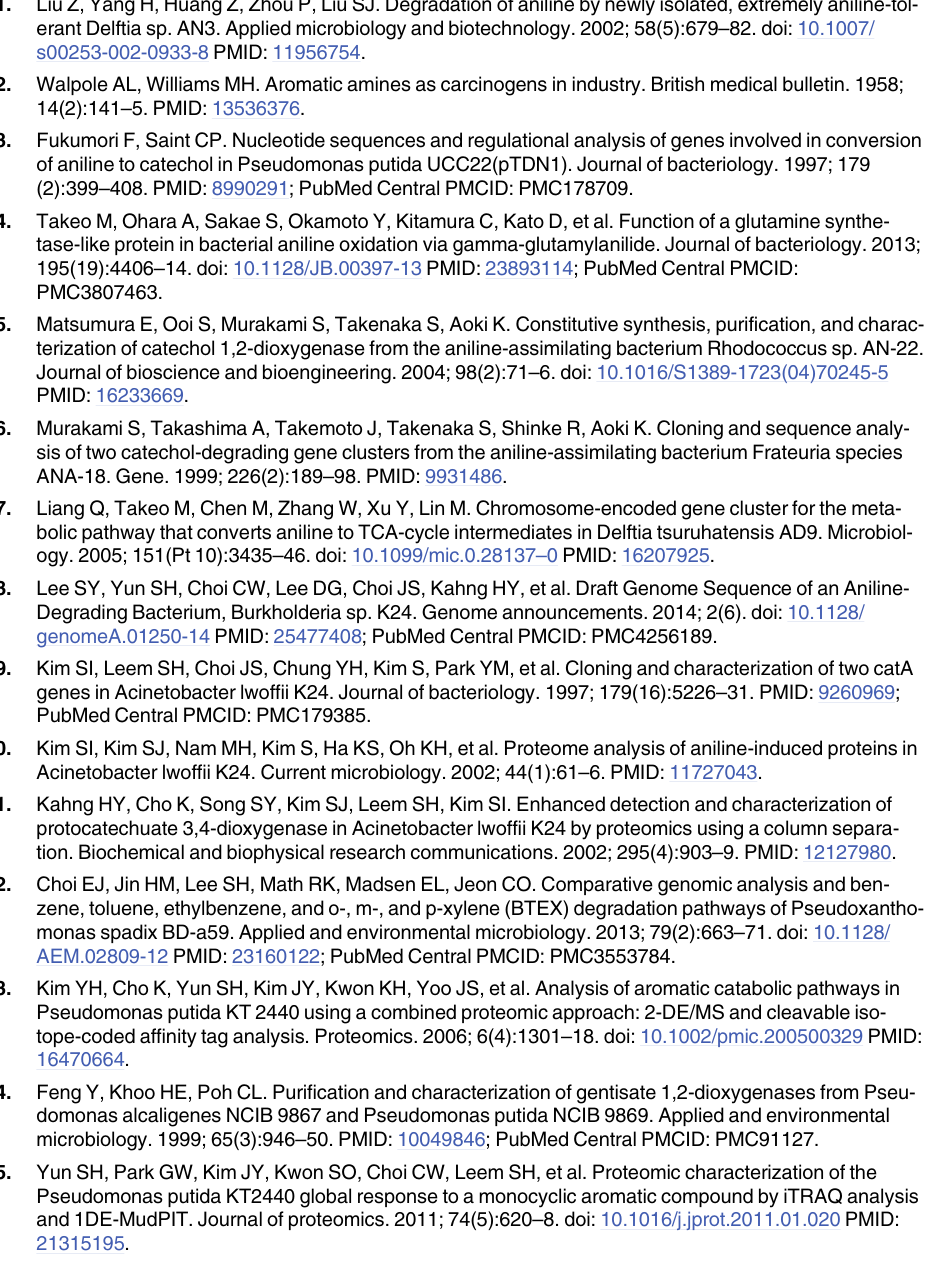
S2 Table. Homology analysis of MAH degradation genes of Burkholderia sp.